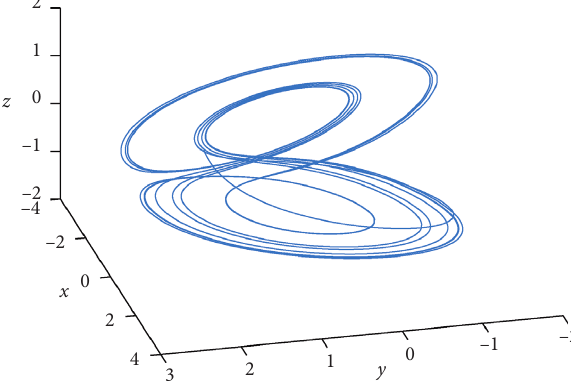
Figure 7: Dynamic behavior of fractional financial chaotic model with α � 0 . 95.